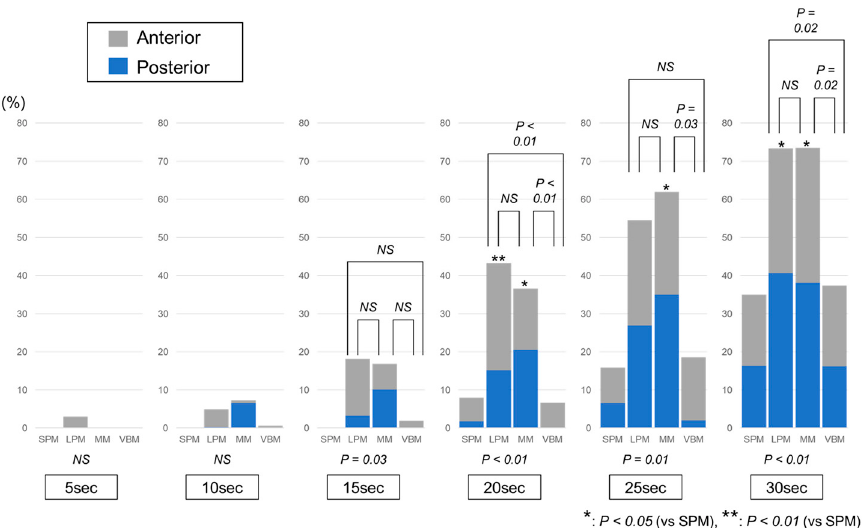
Figure 4. Comparison of the ratios of the total high-temperature areas. The gray and blue bars show the ratios of the high-temperature areas anterior and posterior to the laser tip, respectively. SPM: short pulse mode; LPM: long pulse mode; MM: Moses mode; VBM: virtual basket mode.